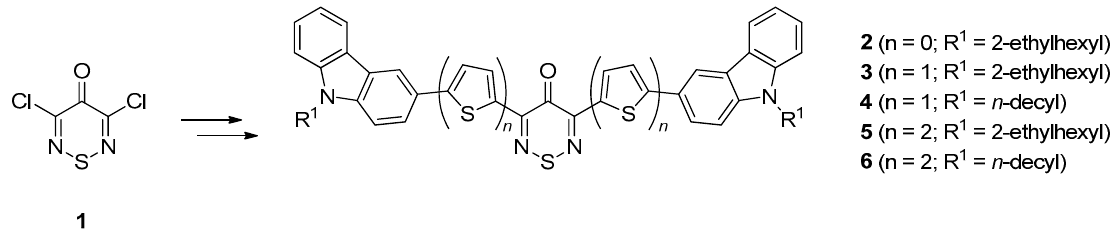
Figure 1. 1,2,6-Thiadiazine containing oligomers studied as donors in bulk heterojunction (BHJ) organic photovoltaics (OPVs) [15].